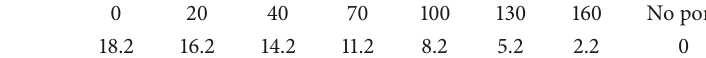
Table 3: Pore pressure and the corresponding water head difference at the excavation face.